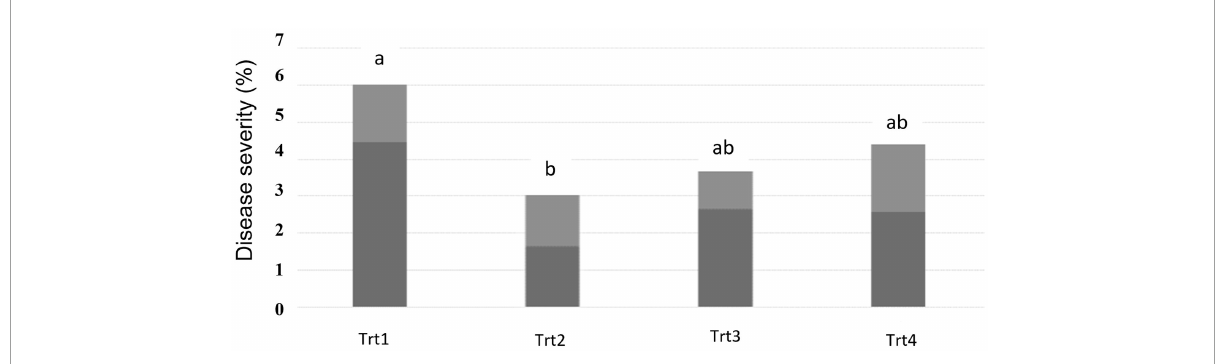
FIGURE2 Fusarium head blight disease severity as assessed at 28 days post inoculation of T6085. Data are the mean (dark gray) + SD (soft gray) percentage of spikelets within a spike showing visual symptoms of FHB ( n = 5 replicates, at 30 spikes assessed per sample). Trt1 was the non-inoculated control. In Trt2, T. gamsii strain T6085 spore suspension was applied to wheat spikes at anthesis. In Trt3, T6085 was applied to crop residue at the soil surface. In Trt4, T6085 was applied to both spikes at anthesis and crop residue. Treatment means indicated by different letters are significantly different (ANOVA with Tukey HSD, p < 0.05).